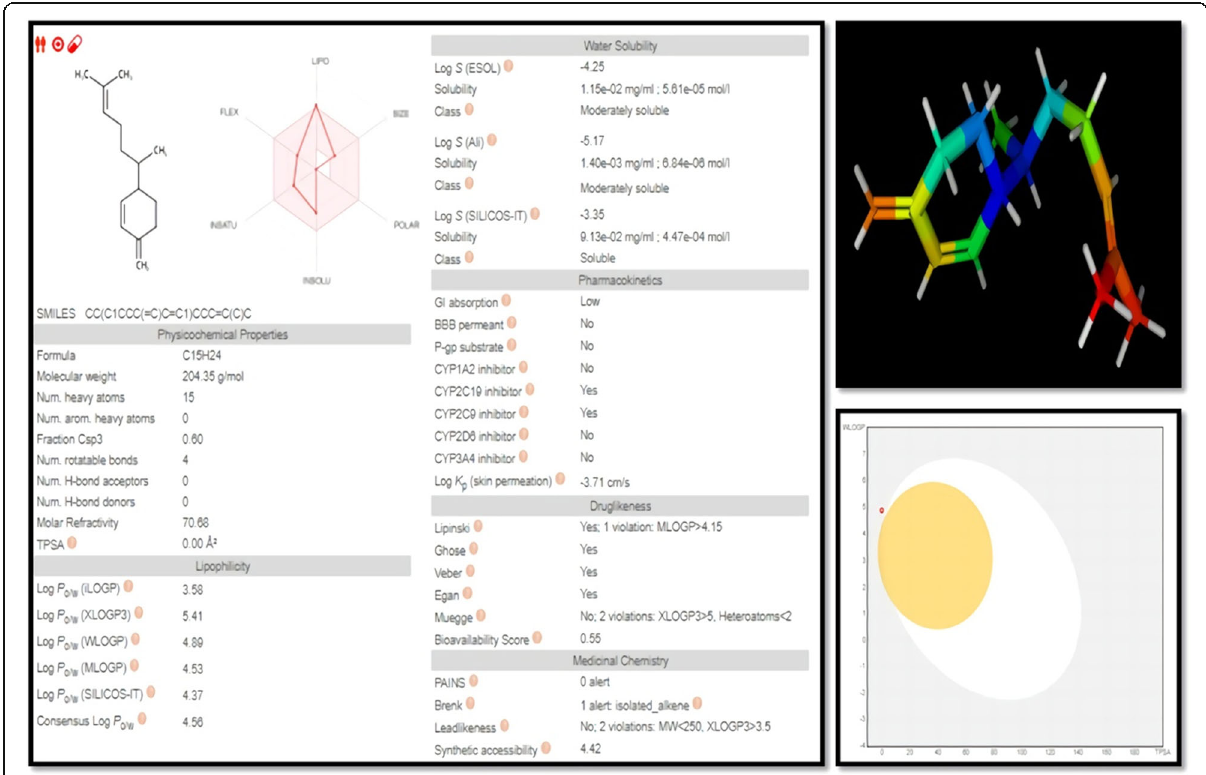
Fig. 2 ADME analysis of beta-sesquiphellandrene along with its three dimensional structure